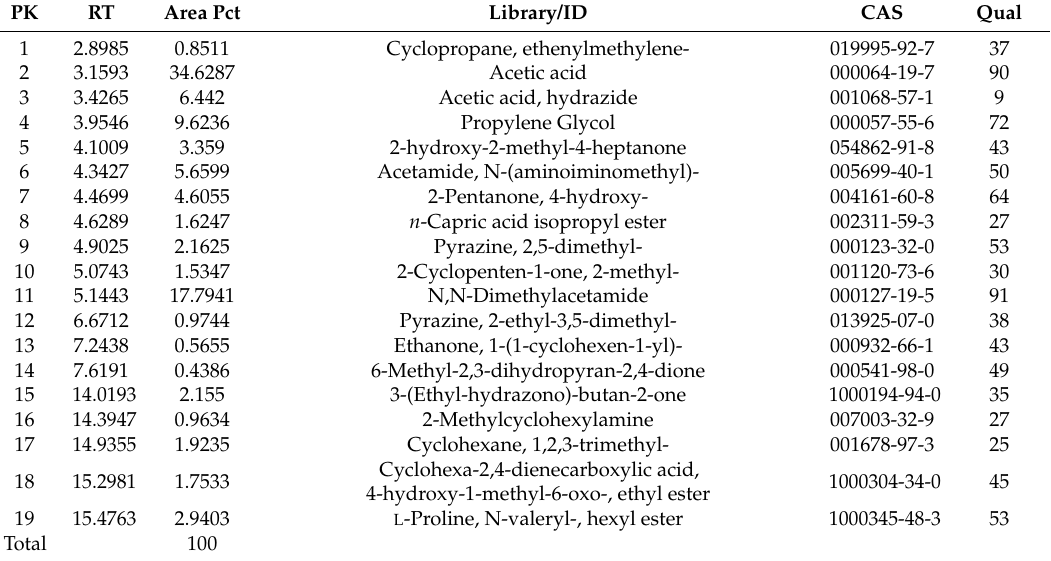
Table 5. GC-MS results of the bio-crude oil obtained from HTL of TPW in water–ethanol medium at 250 ◦ C, 30 min with KOH